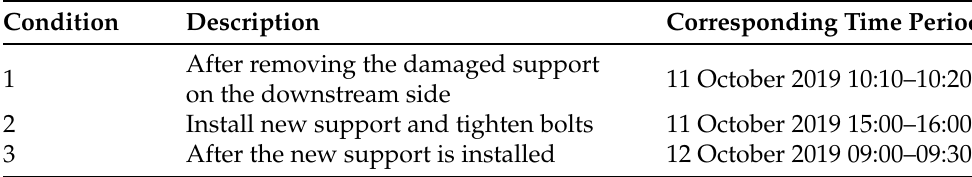
Table 5. Working conditions and the corresponding time period.